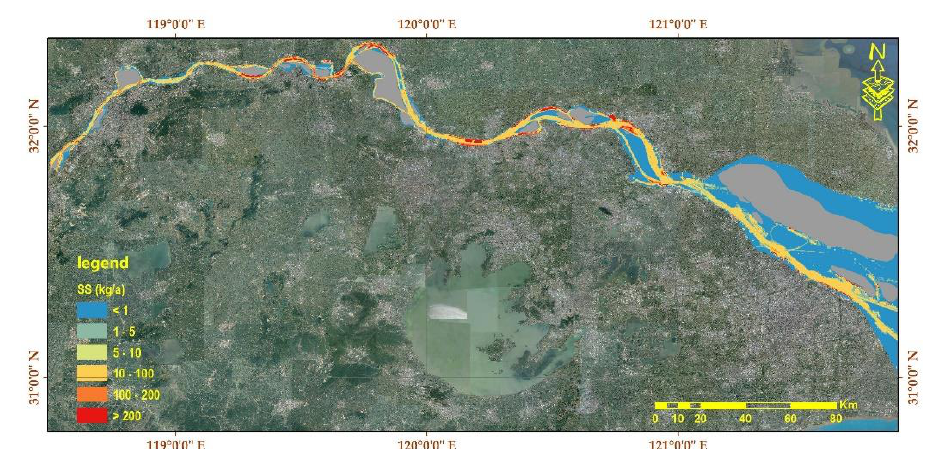
Figure 9. BOD generation distribution.